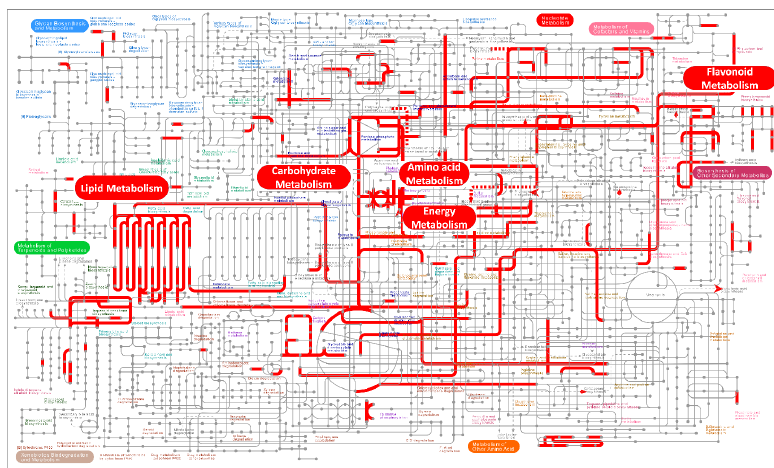
Figure 3. Overview of the metabolic pathways of DEGs between white light (CK) and high-intensity blue light (HBL). The red lines represent pathways annotated by DEGs, and the red boxes represent metabolic pathways that were highly enriched. These metabolic maps were visualized and analyzed by the iPath3.0 online tool (http://pathways.embl.de). Int. J. Mol. Sci. 2019 , 20 , x FOR PEER REVIEW